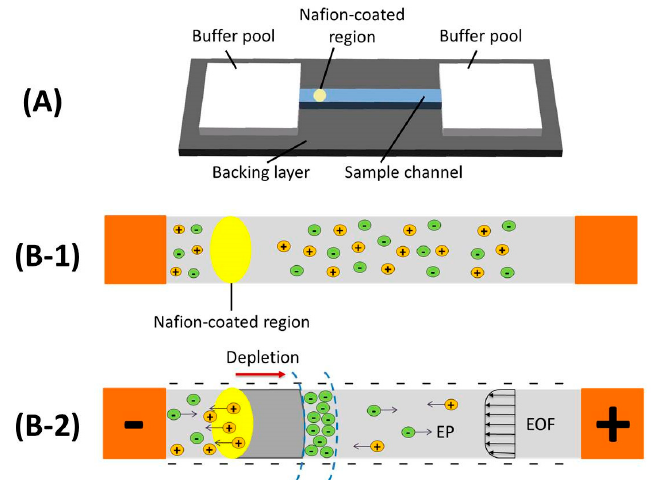
Figure 1. Design and operation of the paper-based ICP device. ( A ) Schematic of device with one sample channel, two buffer pools and one backing layer; ( B-1 ) Schematic of non ICP state without an electrical field; ( B-2 ) Schematic of ICP enrichment and depletion effects under applied voltage.